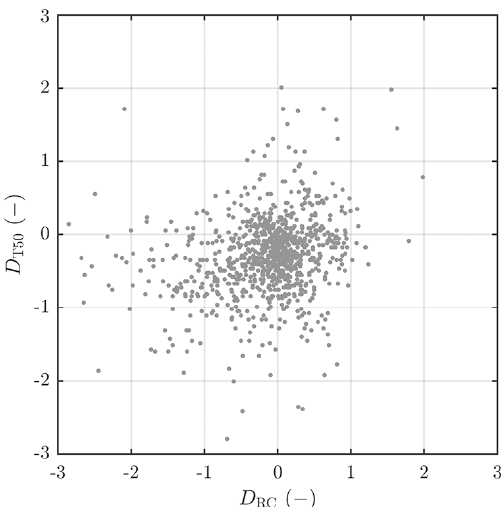
Figure 5. Scatterplot of the difference between simulated (MEAN- All) and observed-transformed RC ( D RC ) versus the difference be- tween simulated (MEAN-All) and observed T50 ( D T50 ) for the catchments ( n =